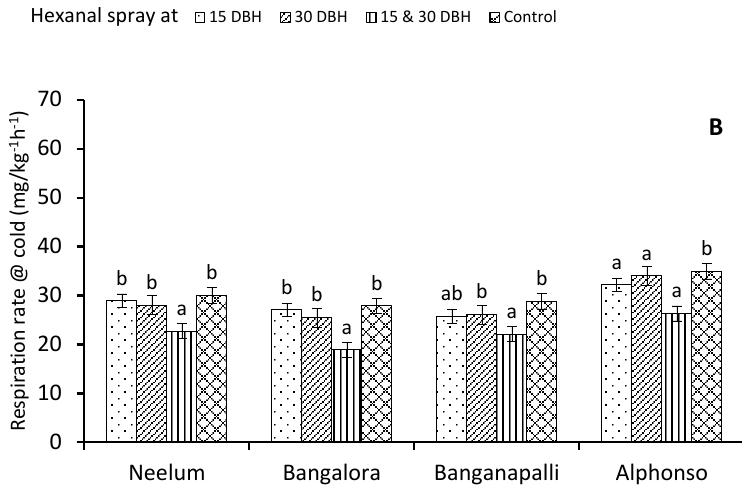
Figure 5. Mean ethylene evolution rate of the hexanal-treated and control mango fruit cultivars during the storage period in ambient ( A ) and cold ( B ) storage condition. The vertical bars in the columns represent the standard error of four replicates (n = 15). Columns with different and the same letters indicate statistical significance and non-significance, respectively ( p = 0.05). DBH—Days before harvest. 3.5. Biochemical Parameters During the storage period, the concentration of solutes present in the fruits differed among the mango cultivars, with the least total soluble solids (TSS) recorded in the cultivar Bangalora. Irrespective of their dosage, the hexanal coating increased the TSS in Neelum fruits compared to the untreated control (Table 2). The amount of total sugars present in the double-dose applied hexanal formulation-treated fruits increased significantly compared to that of the control fruits (Control) regardless of the storage conditions. Similarly to the TSS, the minimum amount of total sugars was noted in Bangalora (Table 1) fruits. The ascorbic acid in the mango fruits started declining during the post-harvest storage period irrespective of the treatment, cultivar or storage conditions (Table 3). Mango fruits imposed with the hexanal formulation treatments had no significance towards increasing the total carotenoids in Neelum and Banganapalli, but not in Bangalora and Alphonso (Table 3). The experimental results clearly indicate that the hexanal formulation had a significant effect in improving the fruit quality irrespective